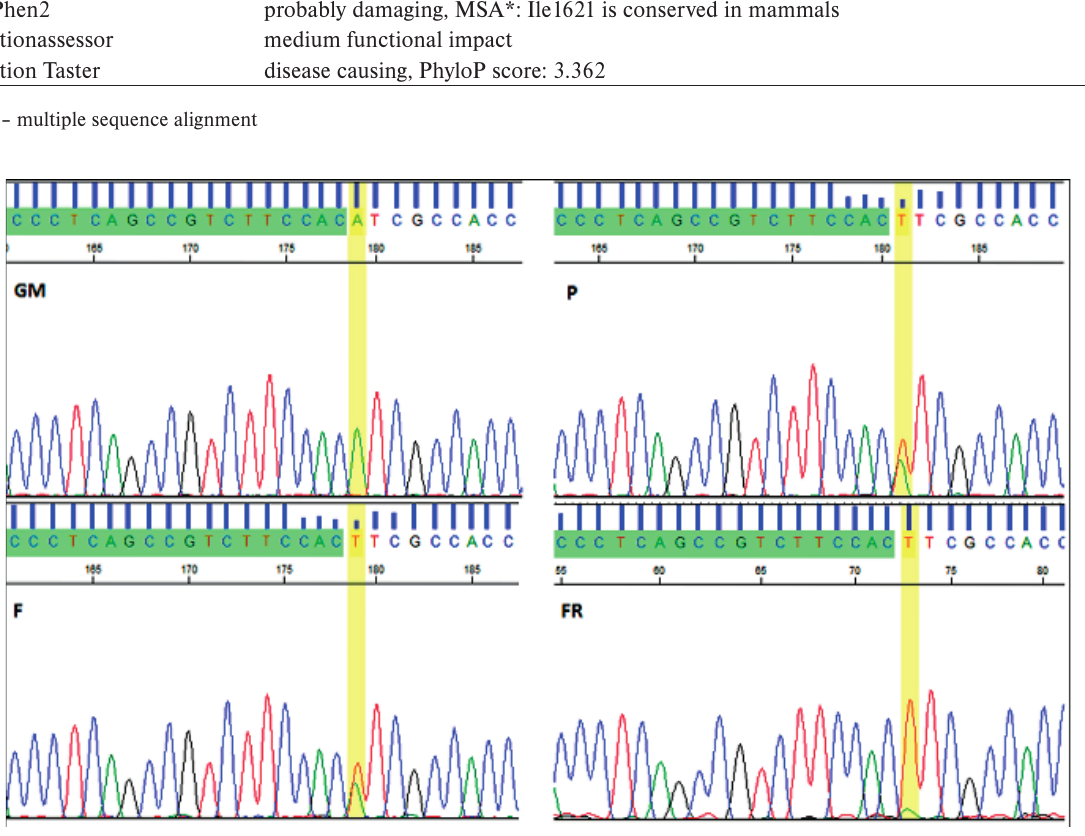
Fig. 1. The sequenograms demonstrate heterozygous presence of c.4861A>T TSC2 mutation (NM_000548.4, ENST00000219476) in father (F) and proband (P), and wild type sequence in paternal grandmother (GM). There is homozygous constitution of the mutation in DNA isolated from cardiac rhabdomyoma of foetus (FR) from second gravidity of proband’s mother – the mutation actually affects only one allele, the second one is affected by deletion (according to the MLPA